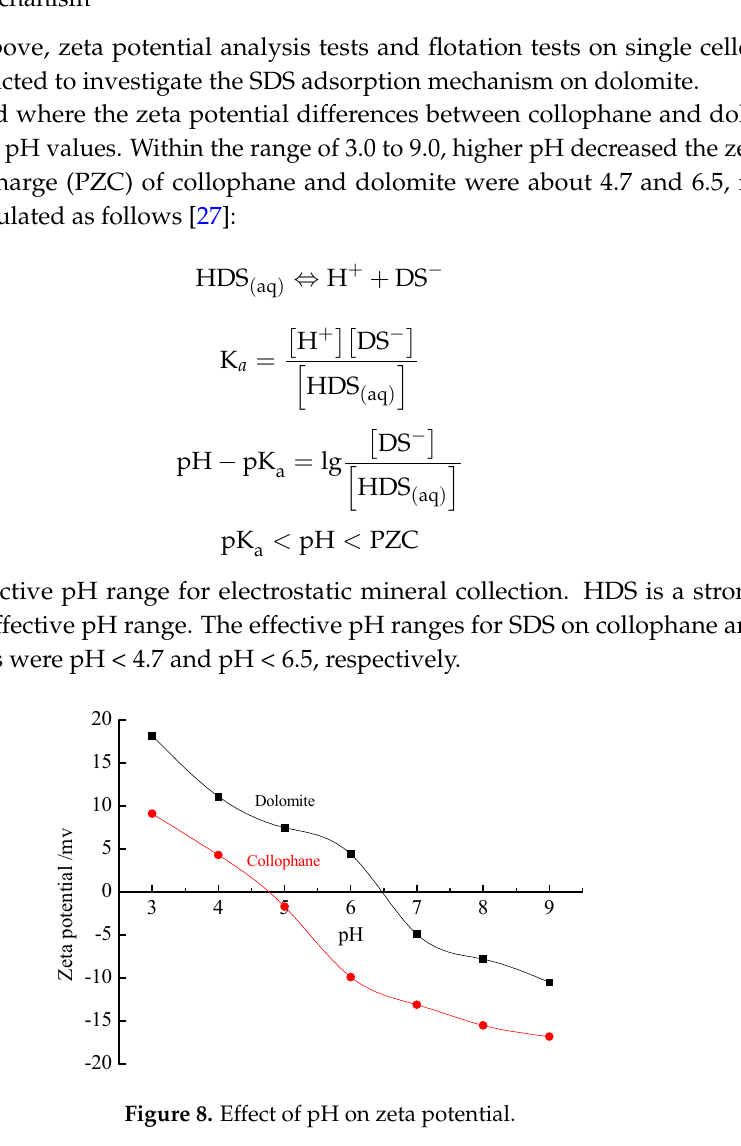
Figure 9. Effect of pH on recovery (SDS dosage is 3 × 10 -4 mol/L).